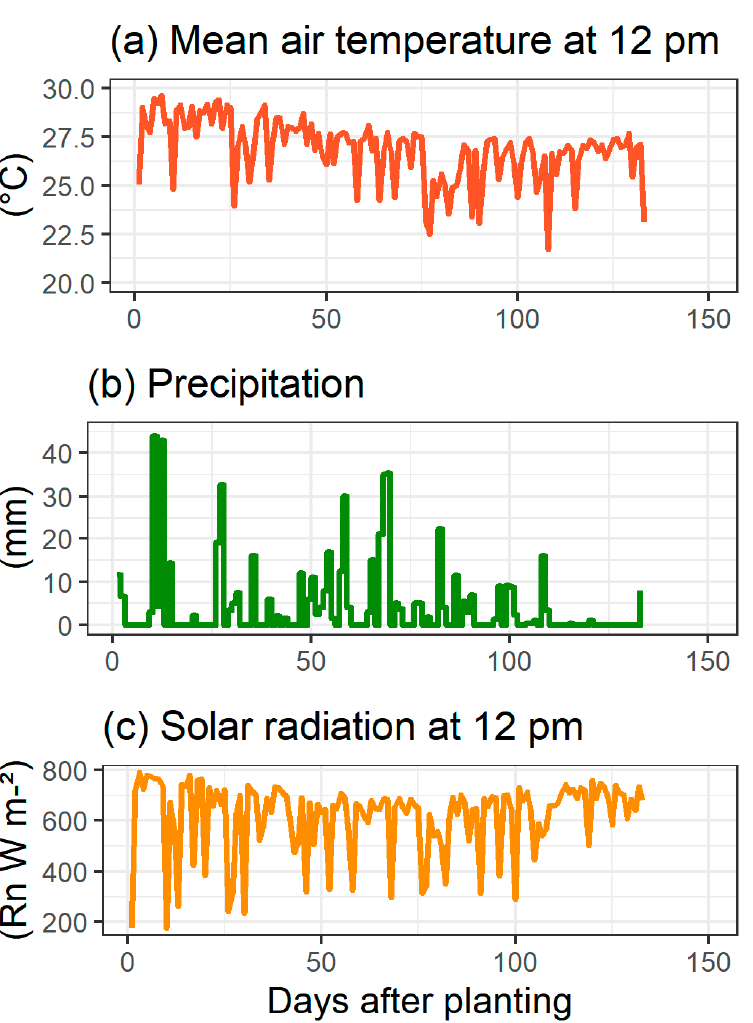
Figure 1. ( a ) Mean air temperature at 12 pm, ( b ) daily precipitation, and ( c ) solar radiation at 12 pm during the experimental period (days after planting) at São Cristóvão, Sergipe, Brazil. Data were acquired from an automated meteorological station 50 m away from the crops.